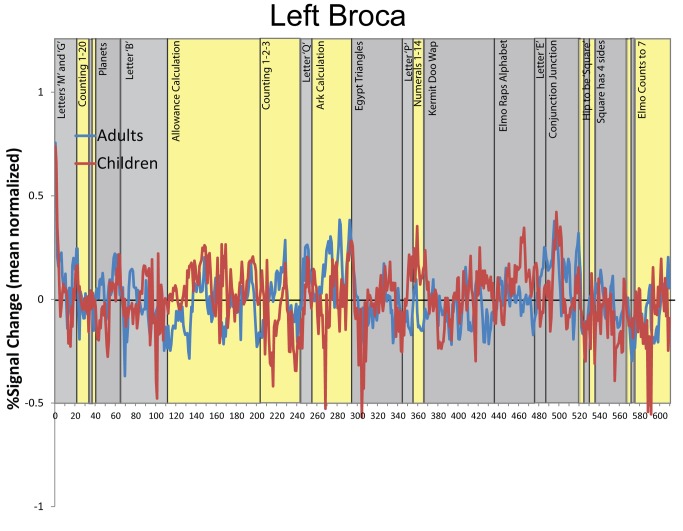
BOLD timecourses of activation from Broca's area from adults (blue) and children (red) from the video series.The timecourses are averaged across the Broca's area voxels from Figure 2B. Percent signal change is calculated relative to the mean amplitude of the timecourse (the zero ordinate represents mean amplitude). The yellow bars indicate time periods where numerical information was presented in the video and the gray bars represent non-numerical video segments.